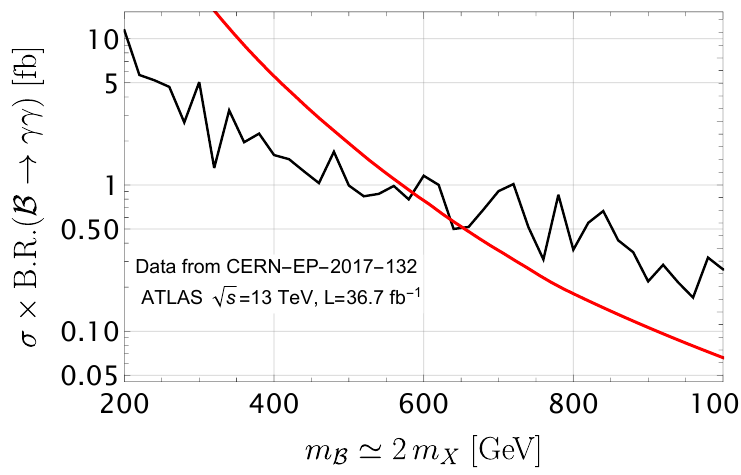
Figure 9. Exclusion limit on the mass of the B ( XX † ) bound state from collider data. The total cross-section for the pp → B ( XX † ) → γγ channel as measured by the ATLAS experiment ( 13 TeV, L = 36 . 7 fb − 1 ) is shown as a solid black line [81]. The red line is our theoretical prediction for the u model considered. We exclude masses whenever this line is above the experimental R